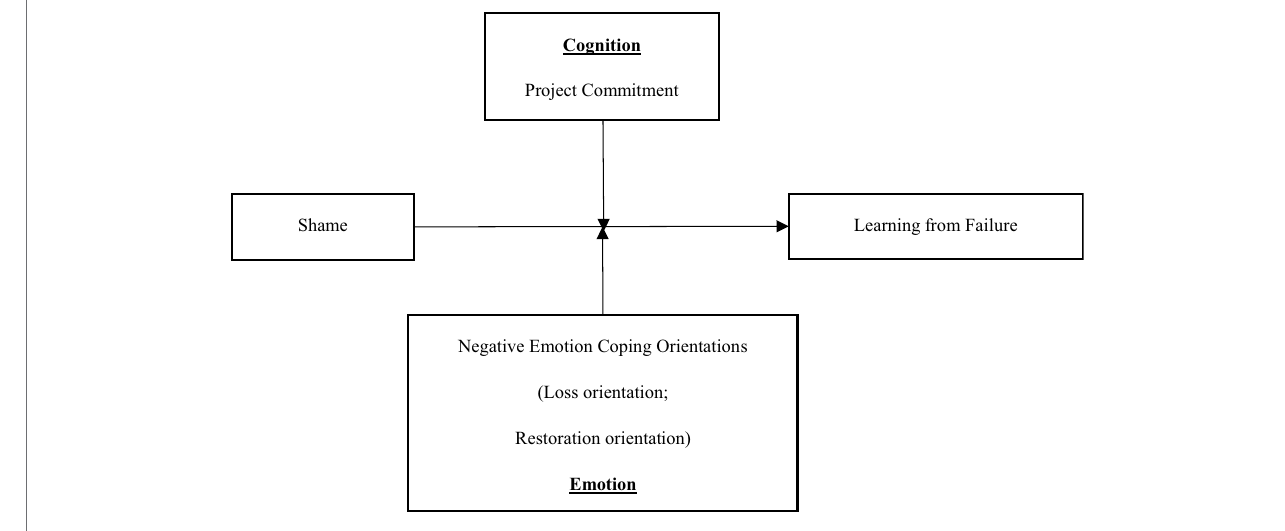
FIGURE 1 | Theoretical